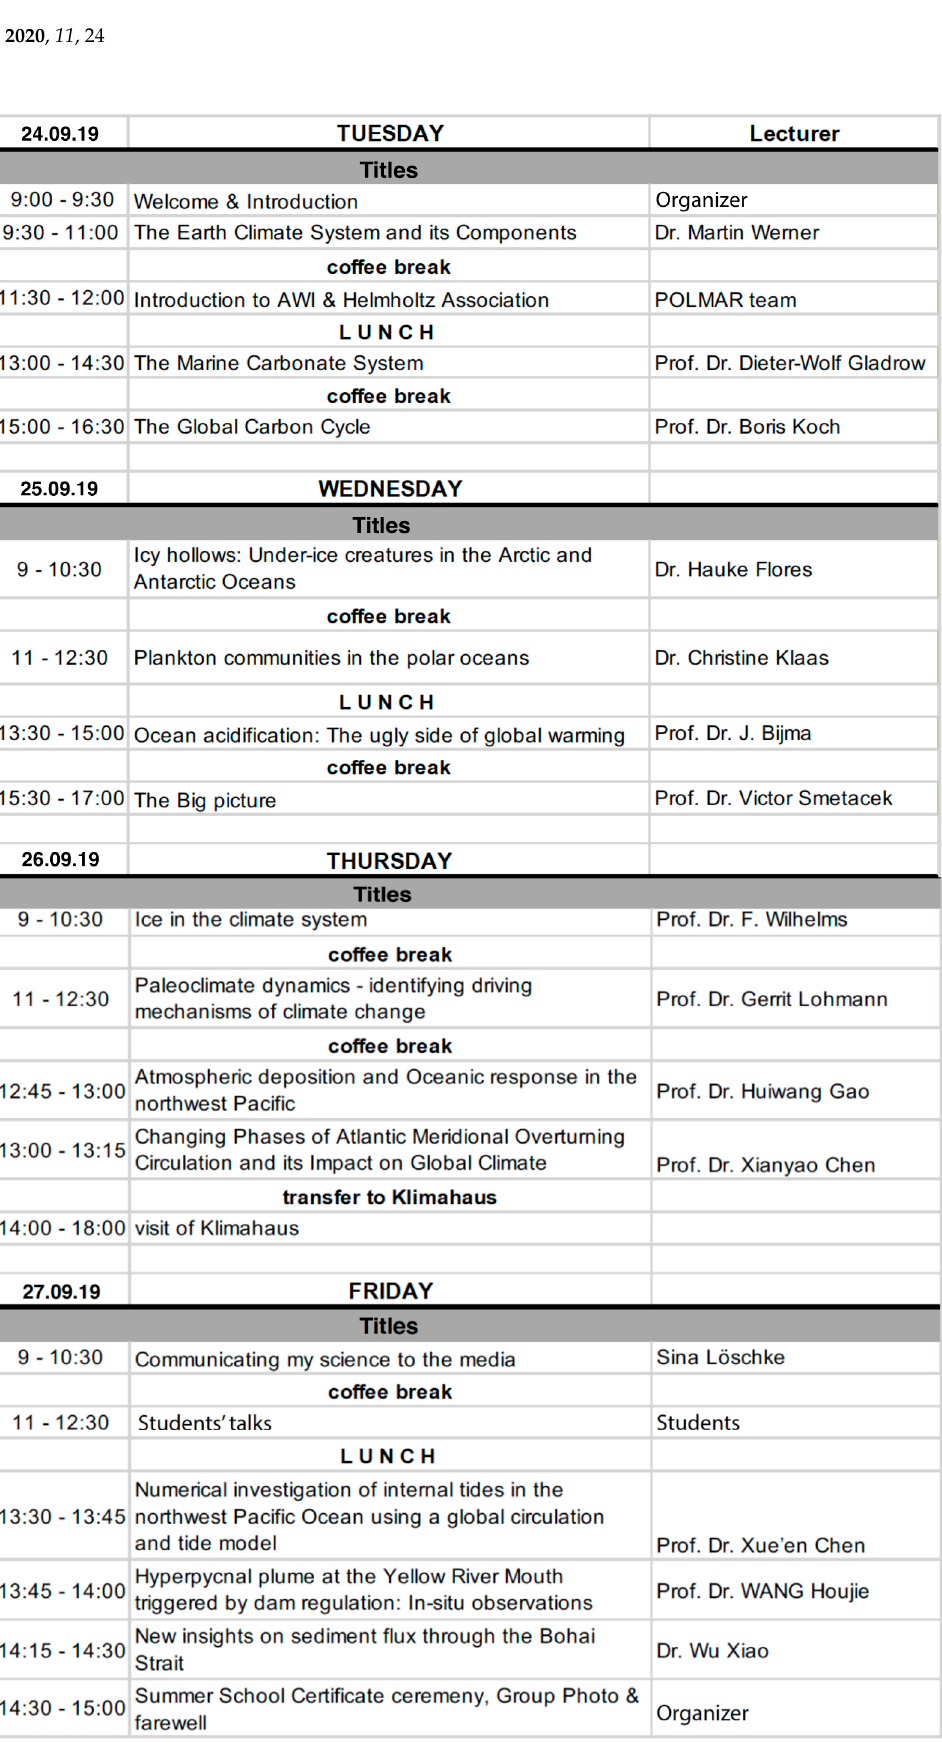
Figure 1. Program of the interdisciplinary Sino-German summer school in Bremerhaven (Germany) in 2019.